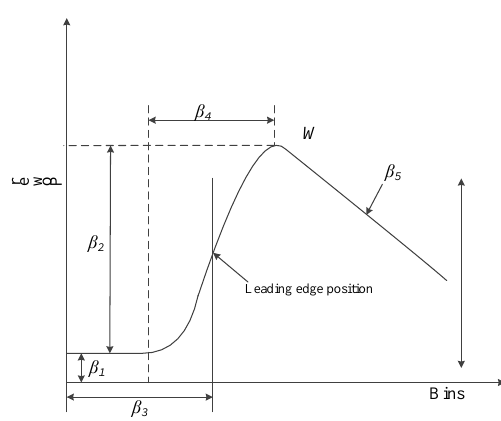
Figure 2. Schematic diagram of 5-β parameter method